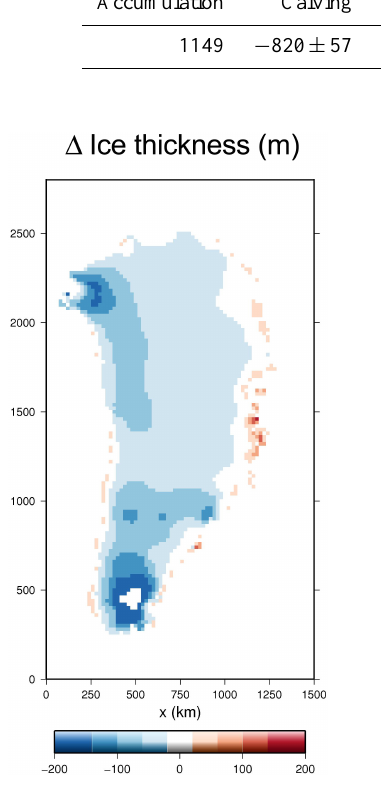
Figure 8. Regions of ice thickness change of the Greenland Ice Sheet in Exp. 3a. We show the change in ice orography between model years 300 and 350 in ma − 1 .